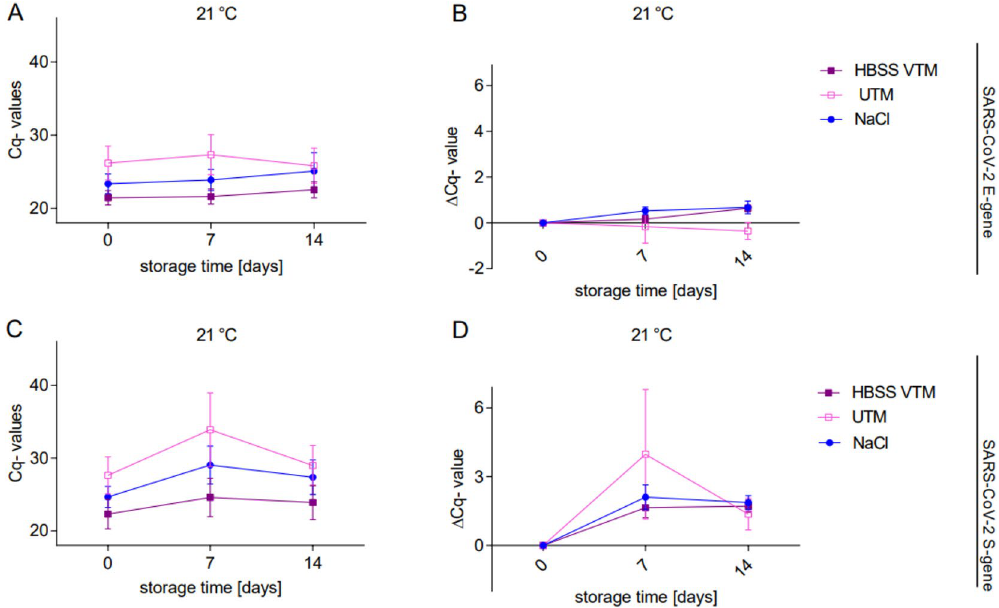
Figure 2. HBSS VTM and saline are both suitable alternatives to UTM as transport media for SARS-CoV-2 specimens. RT-PCR measurements of clinical specimens positive for SARS-CoV-2 stored in NaCl (blue point), HBSS VTM (purple rectangle full) or UTM medium (rose rectangle empty) over 14 days at 21 °C. ΔCq- values ± SEM for NaCl or HBSS VTM n = 16 (12 from Fig. 1 and 6 additional specimens in parallel to 6 in UTM) and UTM n = 6 are shown. * p -values < 0.05, repeated measurement ANOVA. In all groups the viral RNA levels were adequately stable for RT-PCR detection, independent of the storage conditions.